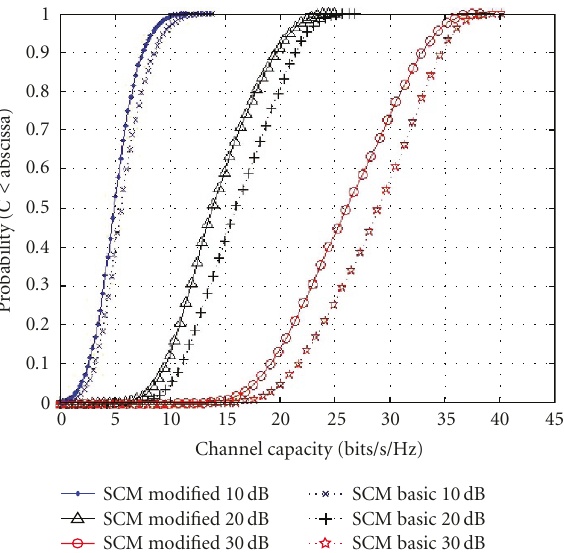
the uniform distribution. The resultant PAS distribution is Laplacian. At the MS, the 20 azimuth values of the subpaths were randomly chosen from uniform distribution, and the relative power values were assigned according to a uniform distribution. As a result, the PAS distribution is uniform. in 3GPP SCM method with fixed subpath angles and in the modified SCM method with random subpath angles. In the modified SCM case, one possible realization of angles and powers is depicted. In the basic SCM, angles and powers al- ways remain unchanged and the specific angular positions of the subpaths define Laplacian